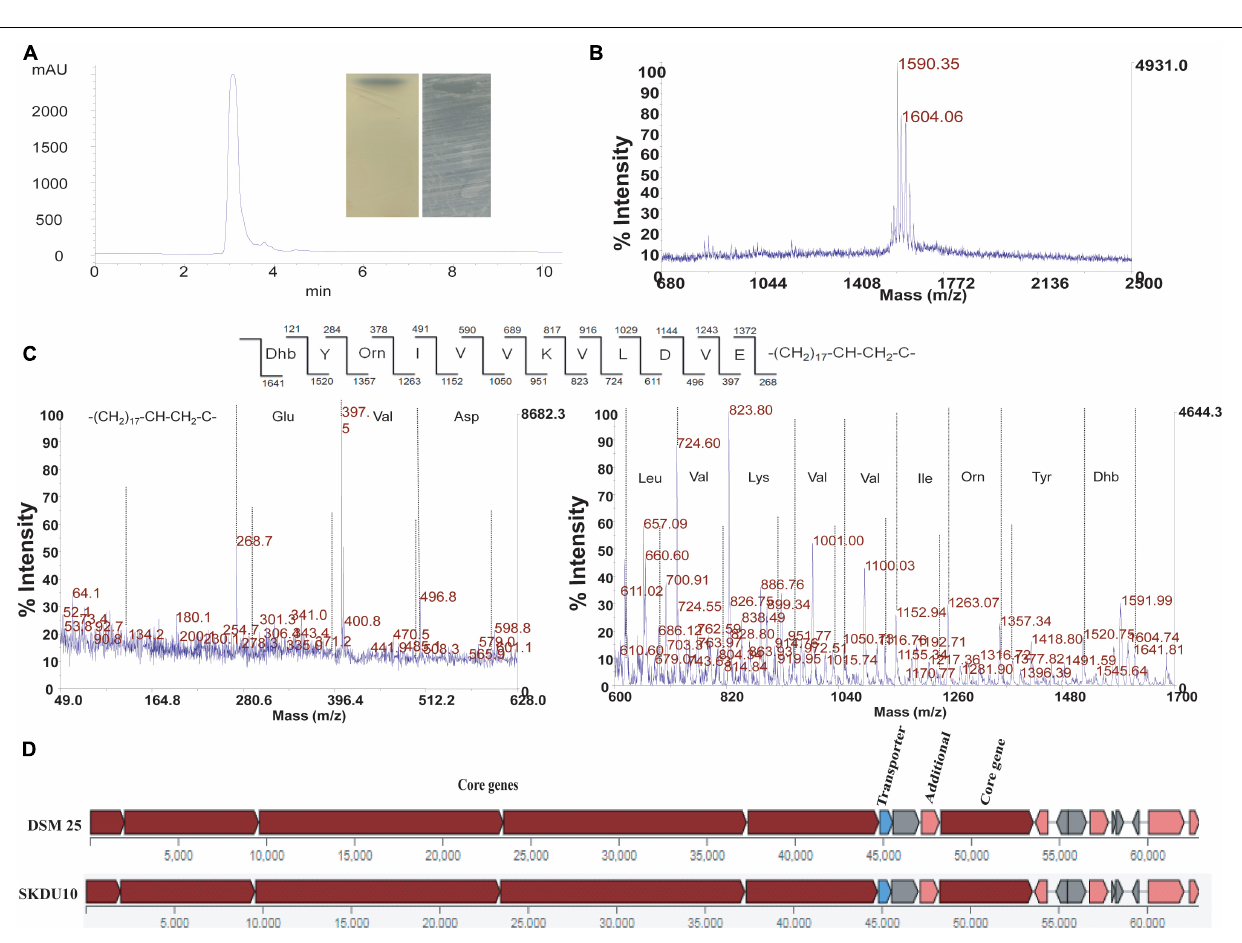
FIGURE 2 | Purification and characterization of antimicrobial compound from strain SKDU10. (A) HPLC chromatogram purified peptide at retention time 3 min. Inset shows phosphomolybdic acid-stained TLC of pure compound and bioautogram with inhibition zone against S. aureus MTCC 1430. (B) MALDI spectrum showing intact mass of peptide m/z 1604 Da. (C) MS/MS fragmentation pattern of bogorol like lipopeptide (BLL) at m/z 1604 Da. (D) Biosynthetic gene cluster from strain SKDU10 consisting of modules responsible for secretion of BLL in comparison to bogorol biosynthetic cluster of B. laterosporus strain